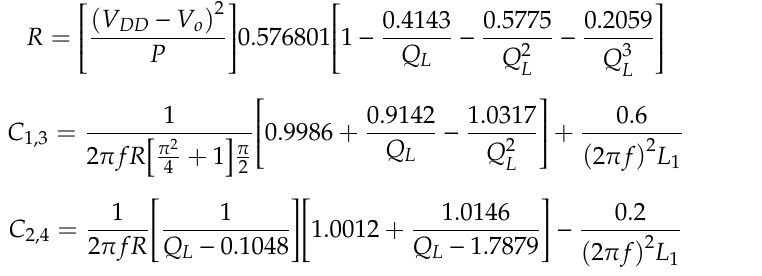
Figure 1. Schematic of two cascaded PAs with inductive load operating at 13.56 MHz.